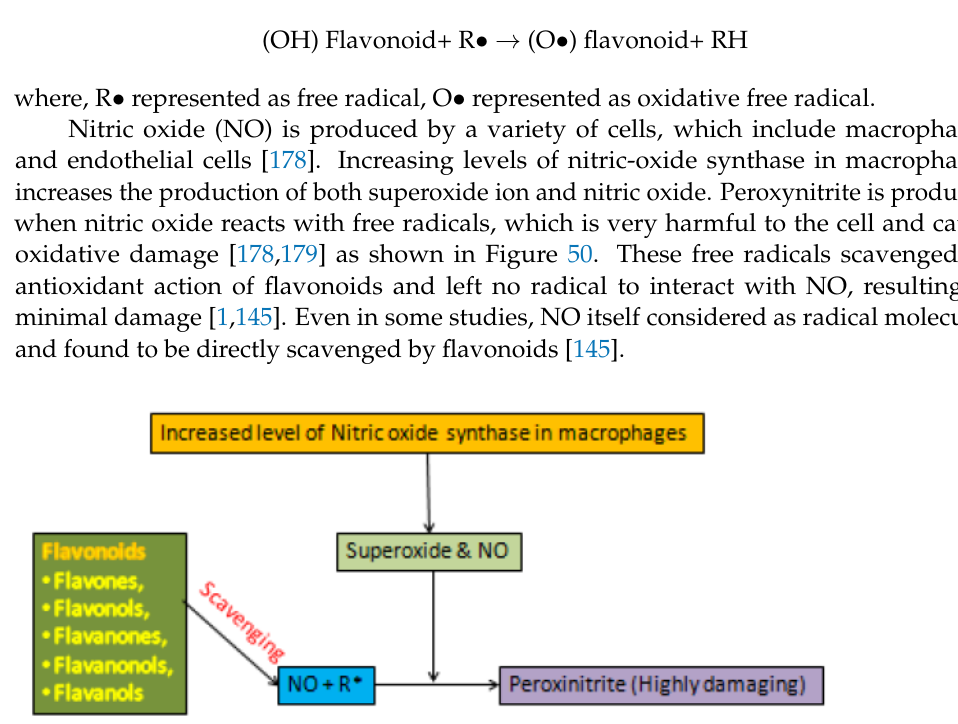
Figure 50. Production of nitric oxide, superoxide and peroxynitrite . NO, nitric oxide; R*, reactive free radicals.